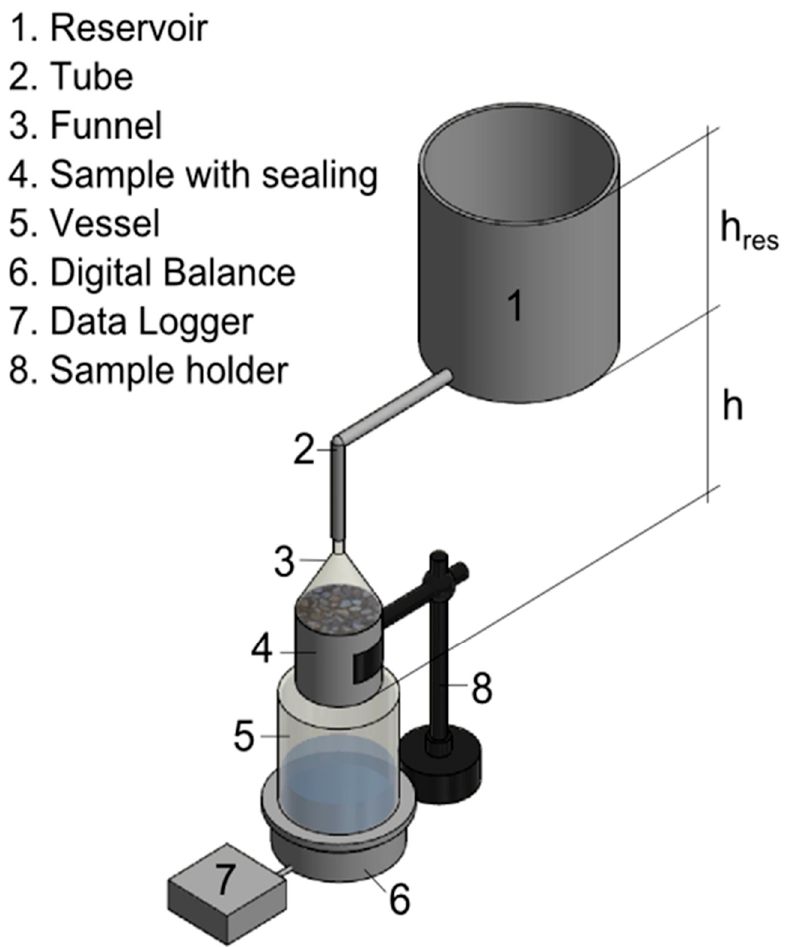
Figure 4. Scheme of the permeation test setup.